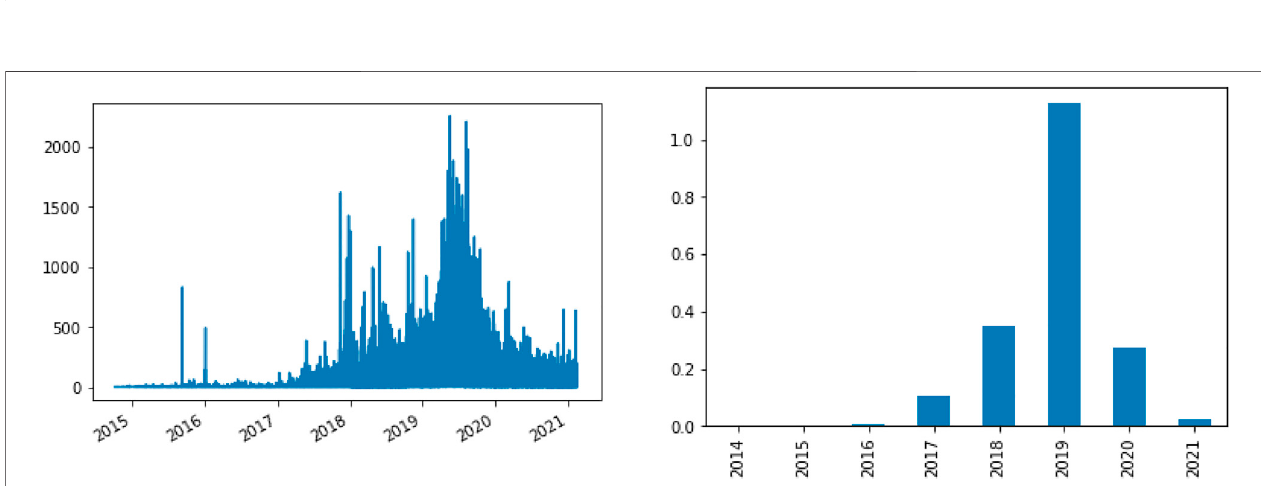
FIGURE 1 | The ten most common transaction types from our dataset. Values on the y axis are reported on a logarithmic scale.